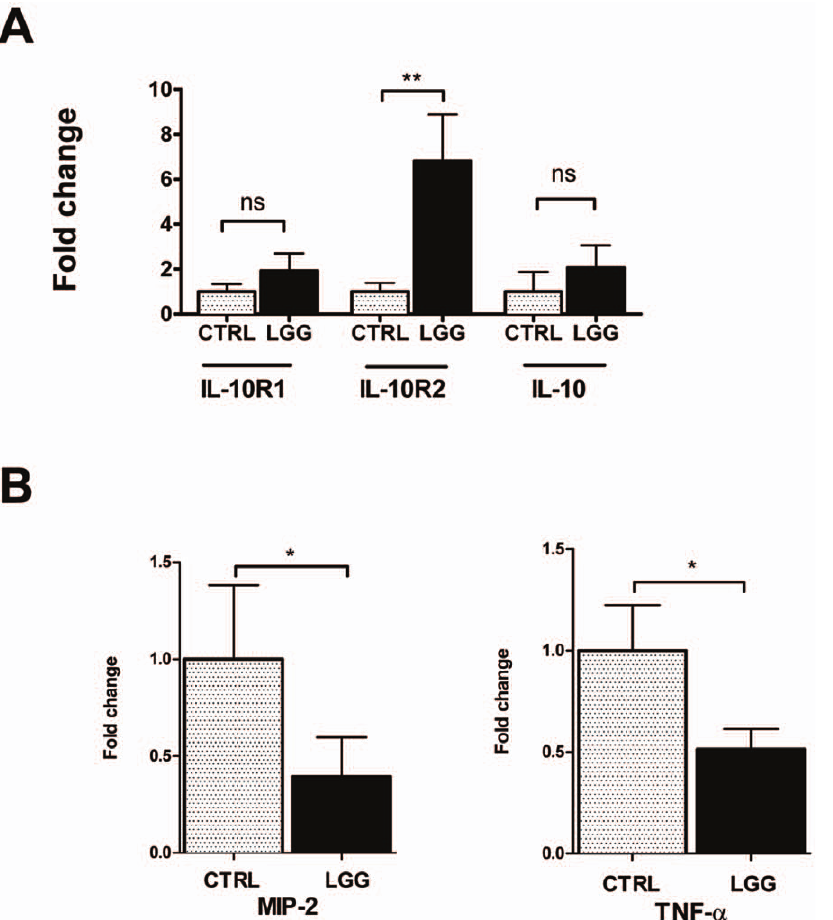
Figure 3. LGG increases IL-10R2 receptor subunit expression and reduces MIP-2 and TNF- a expression in the colon of 2 week-old mice. 2 week-old mice were gavage fed 10 8 CFUs of LGG or equal volume of HBSS, then sacrificed 6 hours later. A. The colon was excised and the mRNA expression of IL-10, IL-10R1, and IL-10R2 was analyzed by real-time PCR. B. Colonic mRNA expression for MIP-2 and TNF- a was measured at 24 hours after LGG or vehicle control. Data are depicted as mean 6 SEM (n=6 2 7 mice per